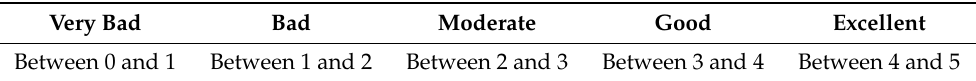
Table 1. QWL satisfaction level scale (Adapted from J ú nior 2008; Timossi et al. 2009). Very Bad Bad Moderate Good Excellent Between 0 and 1 Between 1 and 2 Between 2 and 3 Between 3 and 4 Between 4 and